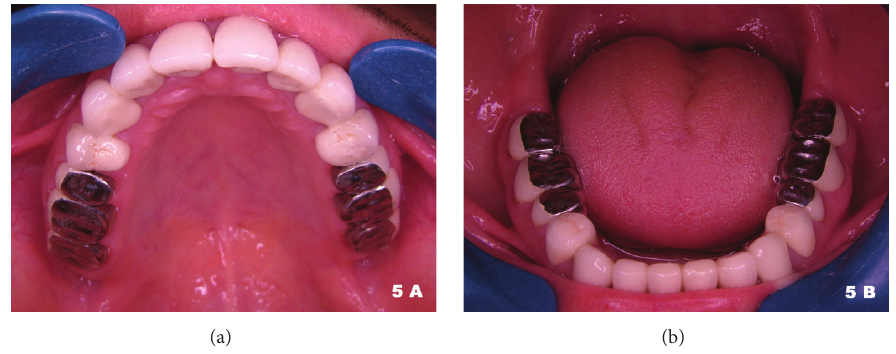
Figure 5: Occlusal view of maxillary (a) and mandibular (b) arches after treatment.